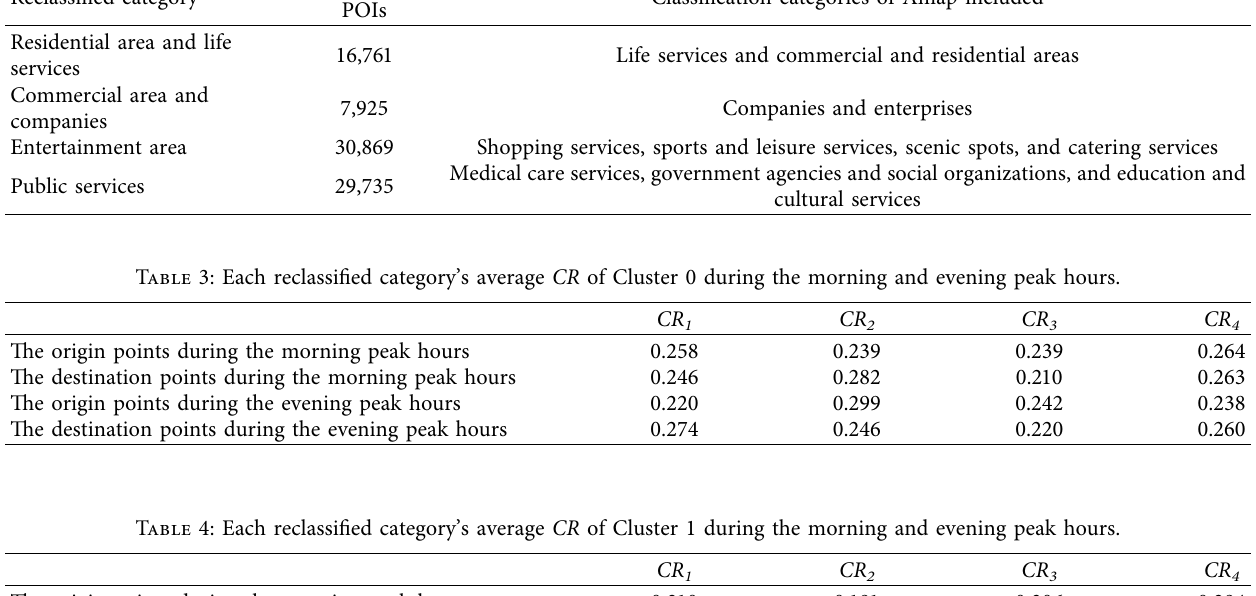
Table 4: Each reclassified category’s average CR of Cluster 1 during the morning and evening peak